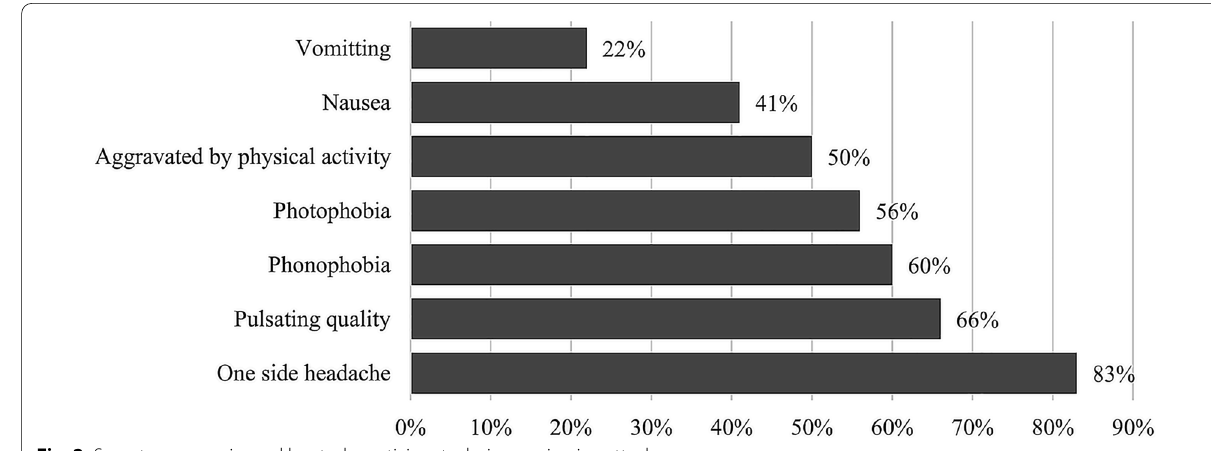
Fig. 2 Symptoms experienced by study participants during a migraine attack